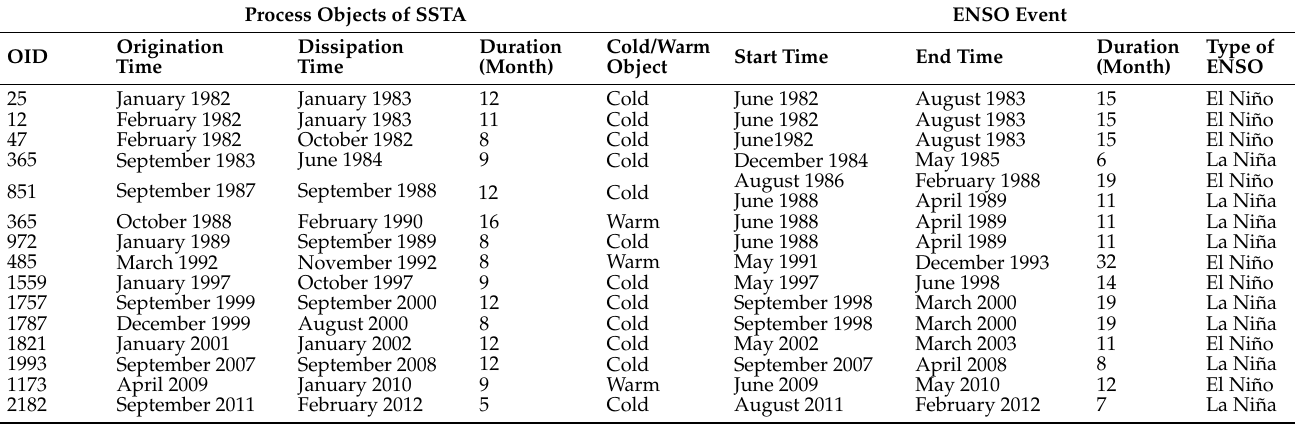
Table 3. Corresponding relationships between process objects of SSTA of type II and ENSO events. OID is the object identifier stored in database; duration of process object of SSTA is the number of months from origination to dissipation of